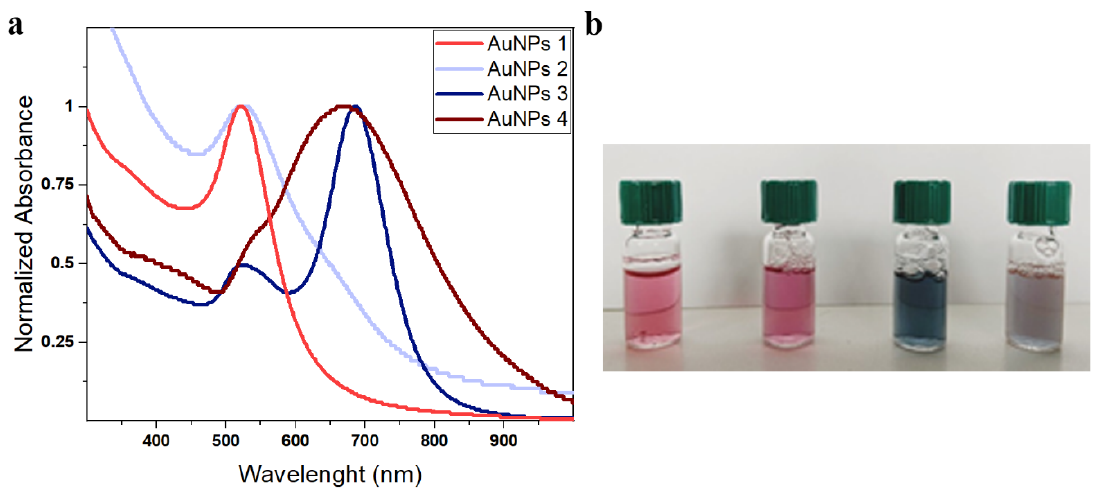
Figure 2. ( a ) Normalized UV-vis spectra of the different AuNPs aqueous suspensions and ( b ) photographs of aqueous suspensions of AuNPs 1, AuNPs 2, AuNPs 3, and AuNPs 4 (from left to right).